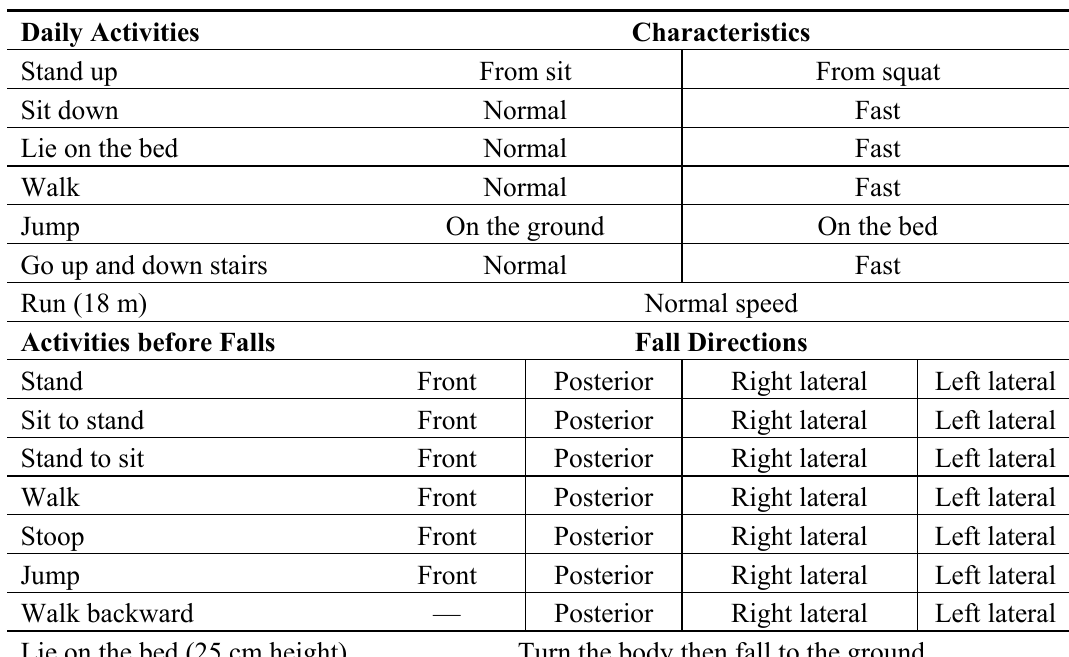
Table 2. The characteristics of falls and daily